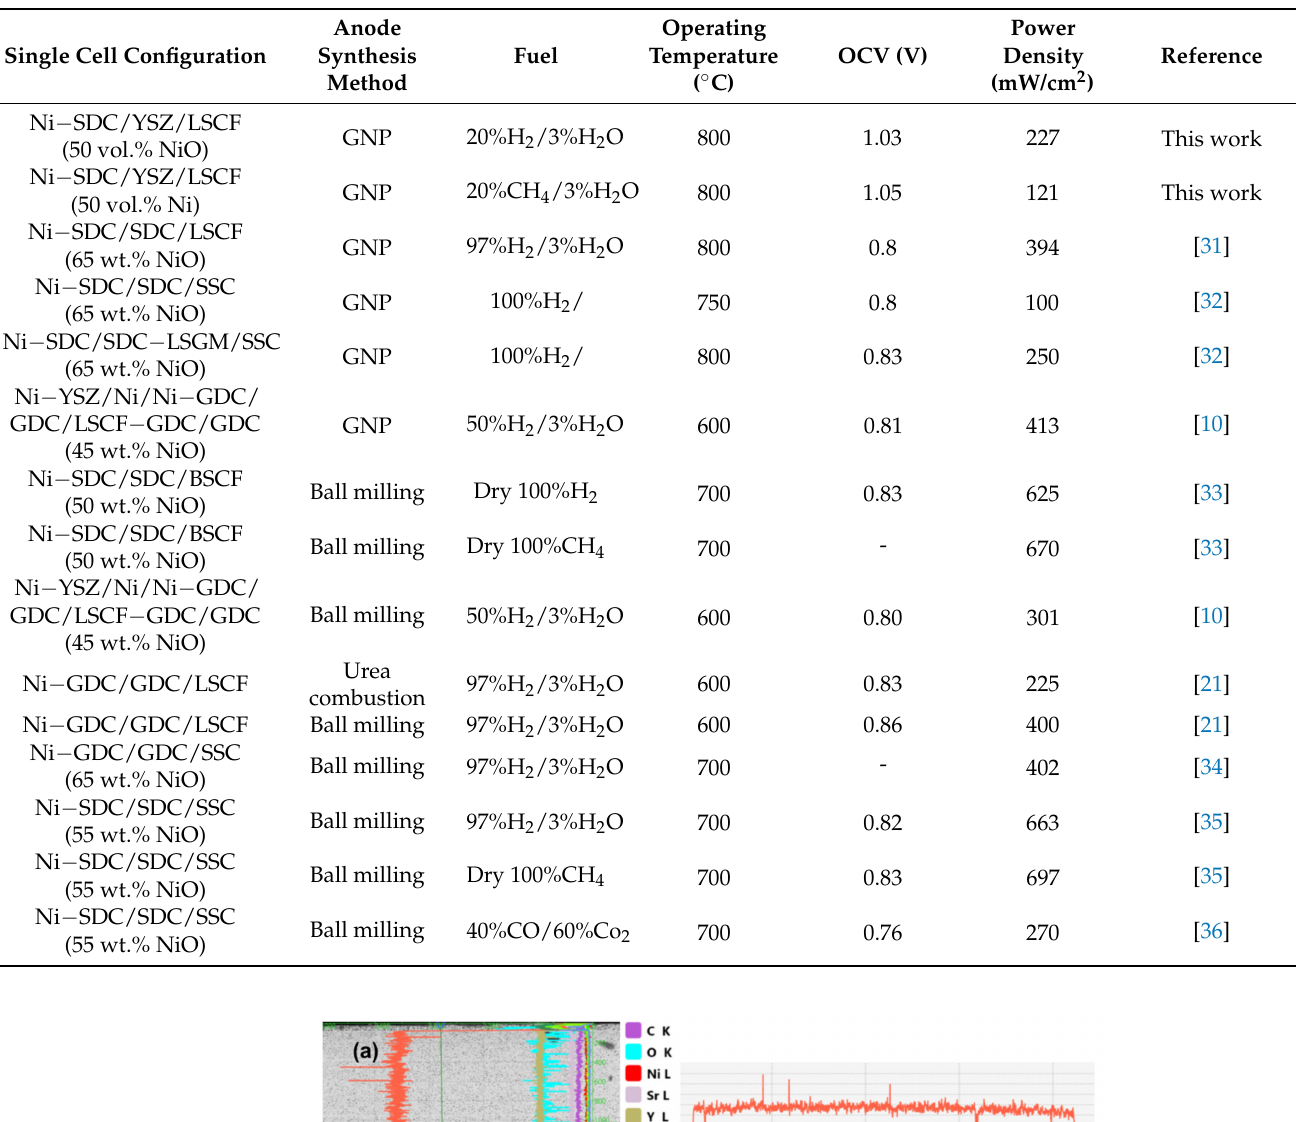
Table 3. Open circuit voltages and maximum power densities of Ni-based composite anode-based single cells tested in hydrogen and methane.